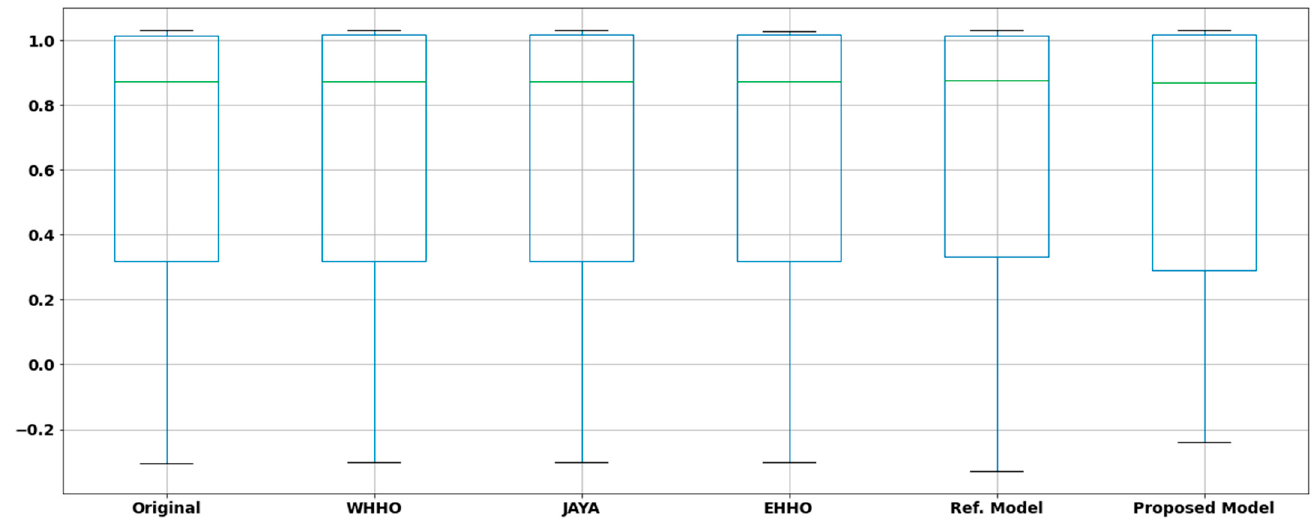
Figure 17. Boxplot of the current variation of the original data, proposed model, and other models from the literature (WHHO [14], JAYA [41], and EHHO [40]) regarding the PWM201 model.